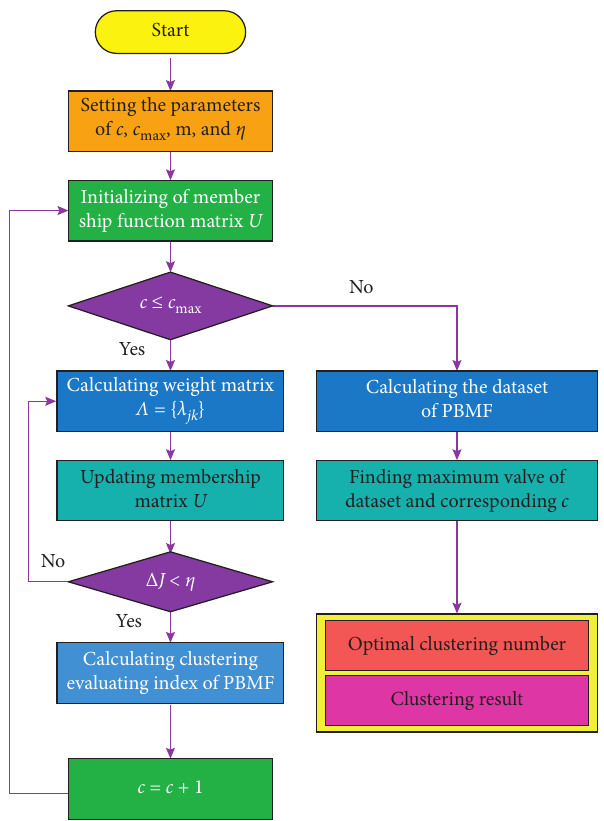
Figure 3: The flowchart of ANW-GK